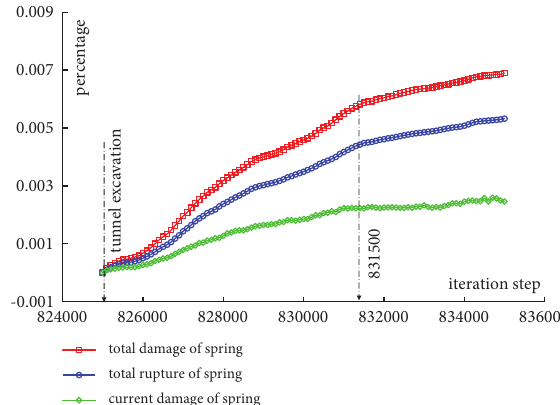
Figure 7: The statistics of spring rupture.